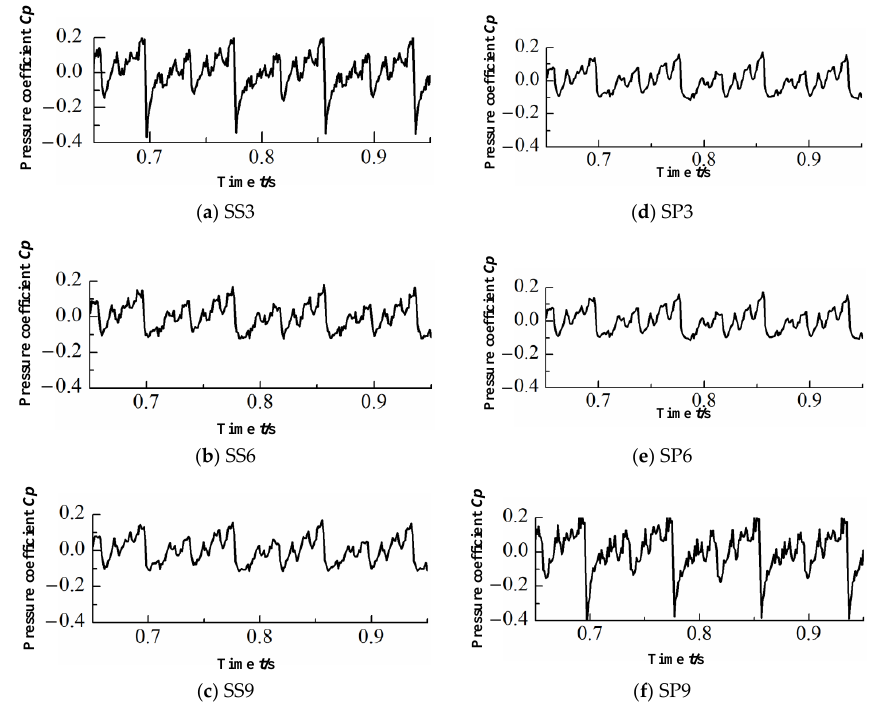
Figure 8. Time domain diagram of single-suction impeller at design flow rate condition. ( a ) SS3, ( b ) SS6, ( c ) SS9, ( d ) SP3, ( e ) SP6, ( f ) SP9